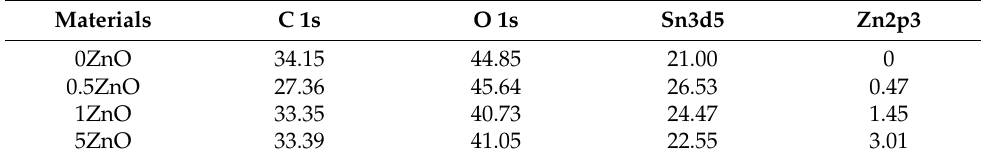
Table 2. The surface composition of ZnO-SnO 2 films.